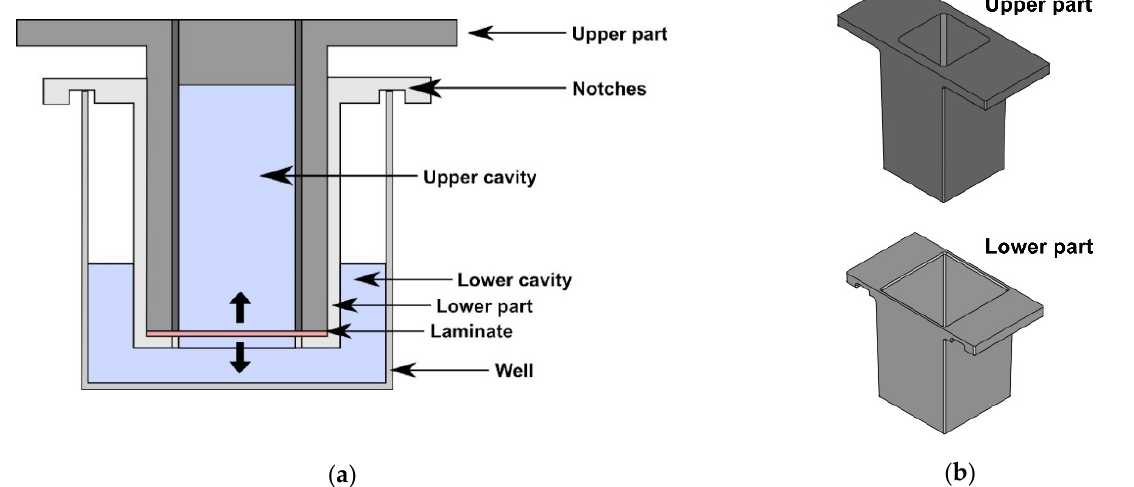
Figure 1. Illustration of the sample holder and its two parts. ( a ) Cross section of the sample holder inserted into the cavity of a 24-well plate. The sample holder consists of an upper and a lower part that are used to position the laminate. If the laminate-loaded sample holder is placed into the cavity of the 24-well plate, an upper and a lower cavity are formed, allowing an analysis of vancomycin release into both directions (thick arrows). ( b ) Isometric view of the upper part and the lower part. The construction drawing was created with FreeCAD (version